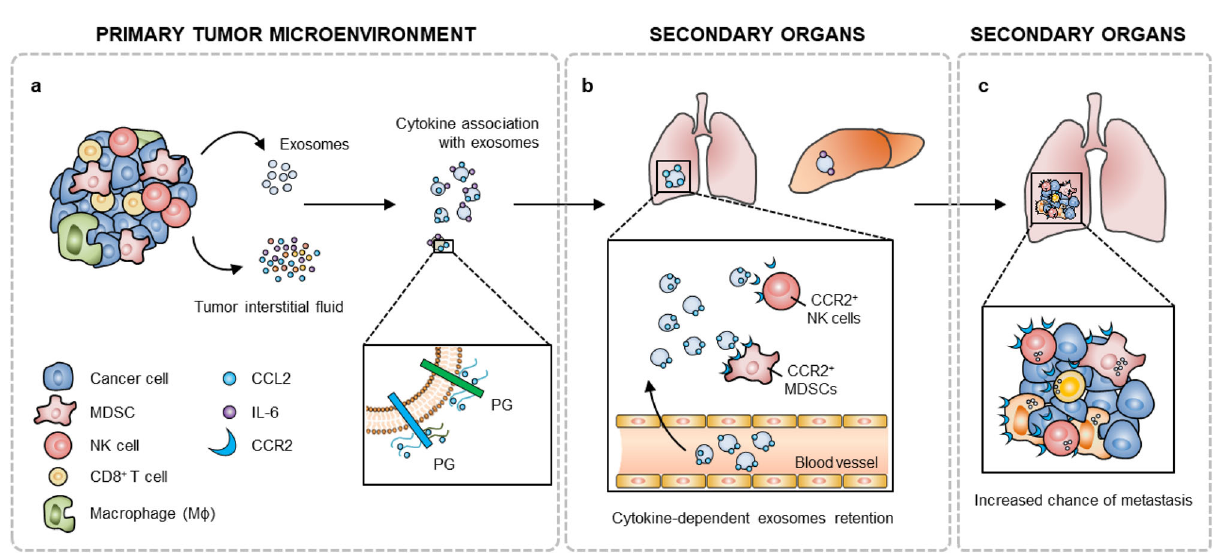
Fig. 6 Summary of fi ndings. a BC-derived exosomes are decorated by cytokines present in the tumor microenvironment. CCL2 (and likely other cytokines) bind to exosomal GAG side chains of proteoglycans (PG) such as CD44, HSPG2, syndecan-1 and versican. b After cytokine conjugation, BC exosomes are predominantly retained into organs such as lung, and display a high af fi nity and preferential uptake by CCR2 + immune cells, such as MDSCs and NK cells. These immune cells, which have interacted with cytokine-conjugated exosomes, contribute to the formation of a metastasis-favorable environment, promoting c subsequent metastatic Transmission electron microscopy (TEM) . TEM imaging was performed using a Cytokine arrays . Cytokines in exosome preparations and TIF were detected using JEOL 1011 transmission electron microscope at 60 kV 30 . Brie fl y, puri fi ed exosomes Proteome Pro fi ler array kits (R&D Systems, human: cat. #ARY022B/mouse: cat. #ARY006), according to the manufacturers ’ instructions. Forty micrograms of total were fi xed with paraformaldehyde and transferred to Formvar-carbon-coated protein were used. Arbitrary values of cytokine abundance were calculated as electron microscopy grids. Grids were transferred to 1% (v/v) glutaraldehyde for 5 integrated densities of each dot plot normalized by the reference spots. Integrated min, followed by eight washes with water. For contrast, grids were negatively densities were measured using the ImageJ software (v1.51w). stained with 1% (w/v) uranyl-oxalate solution, pH 7 for 5min before transferring to methyl-cellulose-UA for 10 min. Excess fl uid was removed and exosomes were fi nally imaged. TIF preparation . EO771 cells (5× 10 5 /mouse) were injected into the 4th right Tunable resistive pulse sensing (TRPS) . Particle abundance and size distribution mammary fat pad of C57Bl/6 mice. After 14 days, tumors were dissected, weighed, were assessed using the qNano system (Izon Science Ltd) by TRPS technology with washed in PBS, and taken into 6-well plates. Tissues were minced in DMEM, and NP100 nanopores and 100-nm calibration beads (CPC100) 30 . incubated overnight at 37 °C, 5% CO 2 . Conditioned media were collected and centrifuged at 500 x g for 10 min. The supernatants were fi ltered through 0.22 µm fi lters (Merck Millipore) and centrifuged at 100,000 x g for 90min at 4 o C to deplete exosomes. Final supernatants were kept at − 80°C until use. TIF cytokine levels were assessed by BD ™ Mouse Soluble Protein CBA Flex Set assay. Flow-cytometric acquisition was completed using a LSRFortessa ™ (BD Biosciences) and the BD FACSDiva ™ software (BD Biosciences, v8), and analysis was performed using the